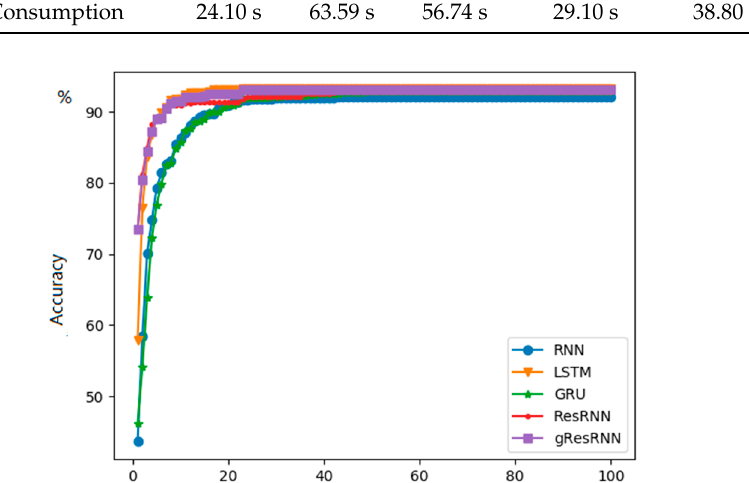
Figure 3. Best F1 values for the RNN [9], LSTM [16] and GRU [17] and Res-RNN, Res-RNN with gates over epochs.